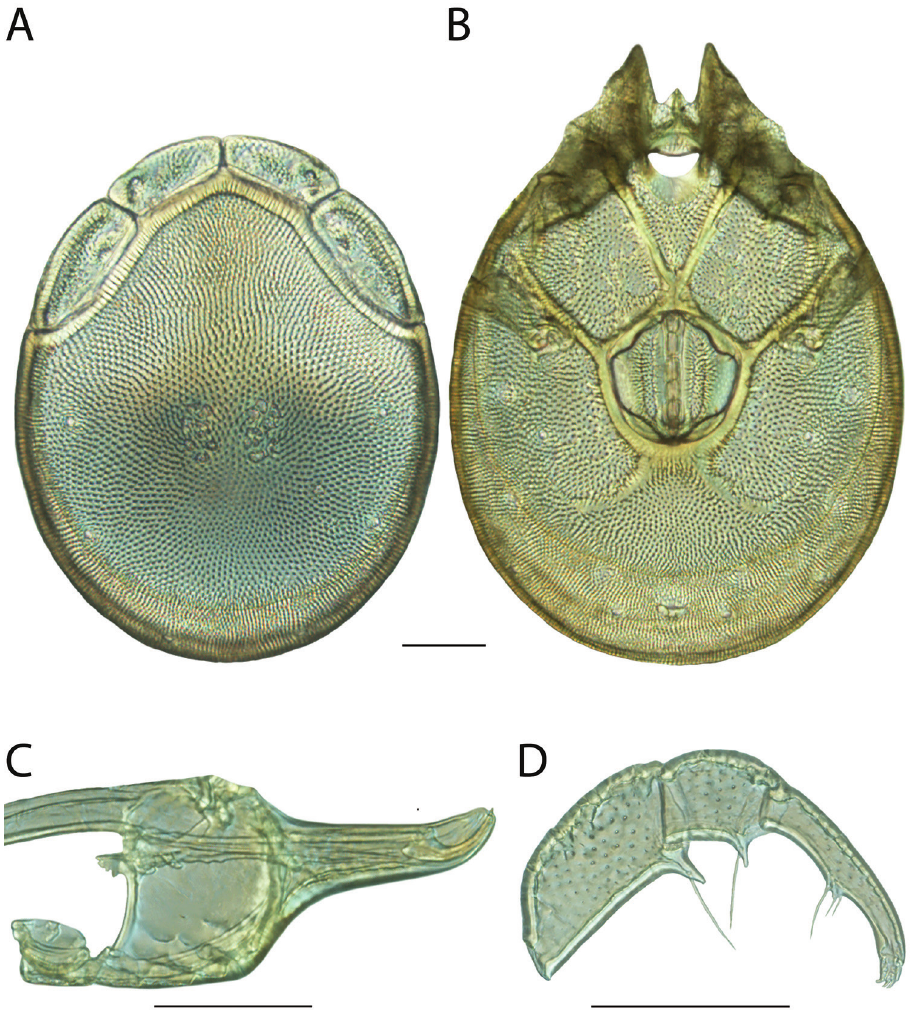
Figure 215. Torrenticola raptoroides sp. n. female: A dorsal plates B venter (legs removed) C subcapitulum D pedipalp (setae not accurately depicted). Scale = 100